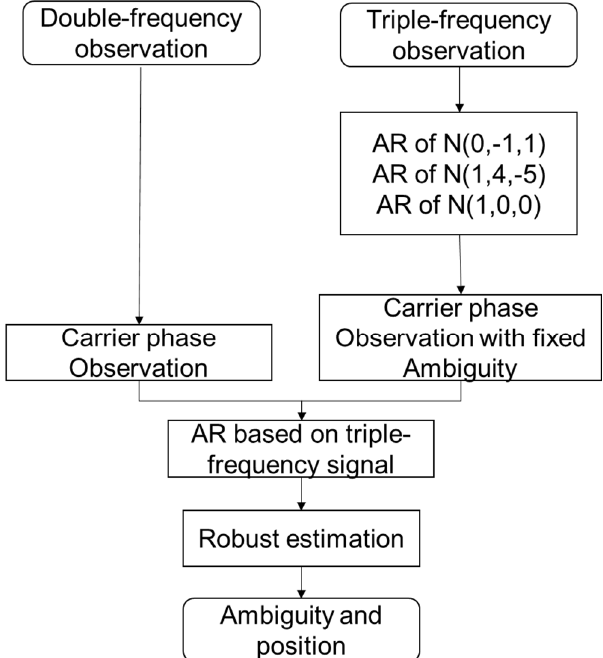
Figure 1. Structure of the new single-epoch Global Navigation Satellite Systems ambiguity resolution (GNSS AR) method for a short-range baseline based on triple-frequency signals.